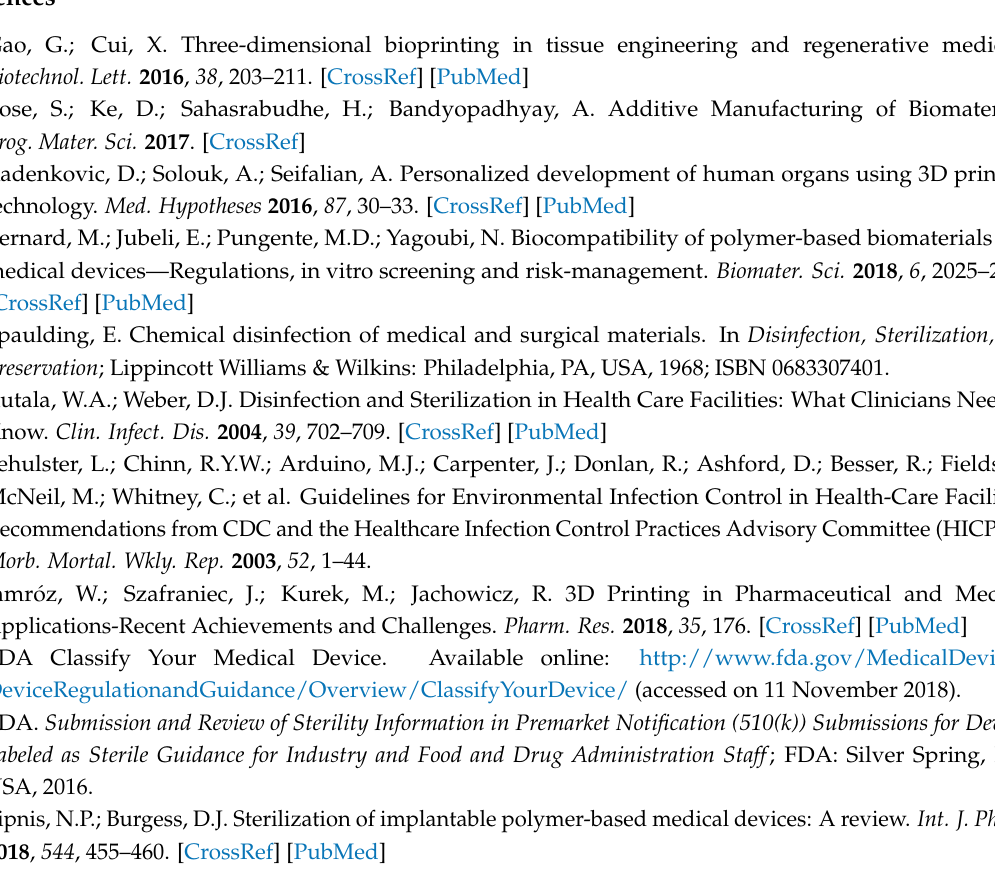
high-pressure. (Figure S1: Example of the specimens manufactured with (a) DLP, (b) FDM and (c) SLA technologies, used for the surface and geometrical characterization, Figure S2: Alicona machine surface characterization sample images, Table S1: Measurements with digital caliper before HHP processing. Dimensions are in mm, Table S2: Measurements taken with the Alicona before HHP processing on DLP sample #1, Table S3: Measurements with digital caliper after HHP processing. Dimensions are in mm, Table S4: Measurements taken with the Alicona after HHP processing on DLP sample #1. Dimensions are in mm, Table S5: Caliper-measured dimensions changes after HHP processing. Absolute maximum values shown in bold, Table S6: Dimensions changes measured for DLP sample #1 on the Alicona machine. Dimensions are in